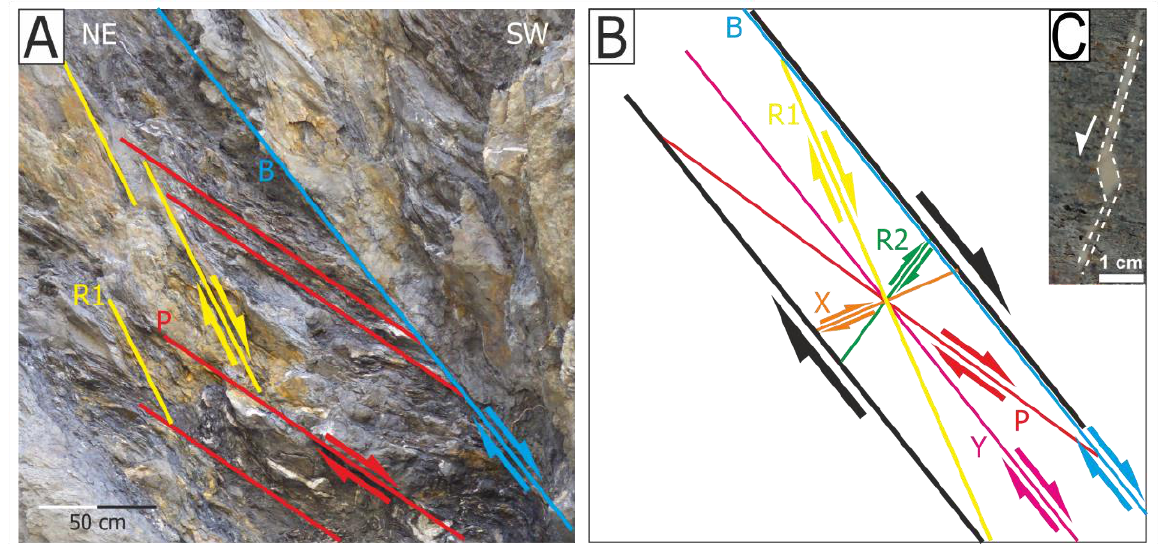
Figure 3. Kinematic interpretation of fabrics of the fault core. ( A ) Riedel planes inside the fault core; ( B ) schematic pattern of Riedel shear planes that usually develop in a brittle shear zone; modified after Ikari et al. 2011 [56]. ( C ) Extensional jog, with antithetic kinematics (parallel to R2), seen in the hand sample.